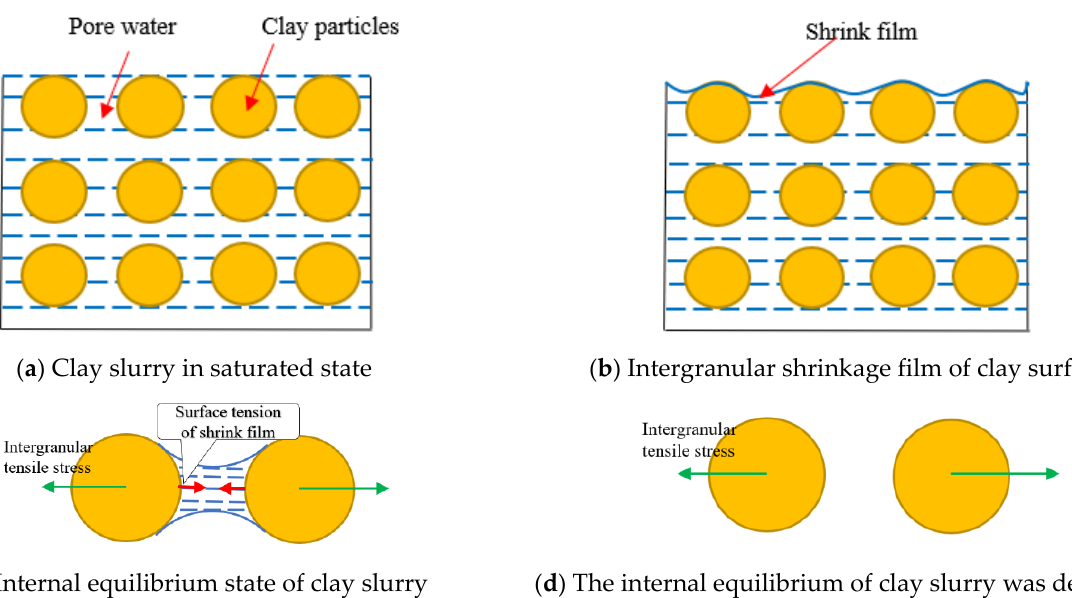
Figure 6. Mechanism of fracture formation during clay slurry drying.